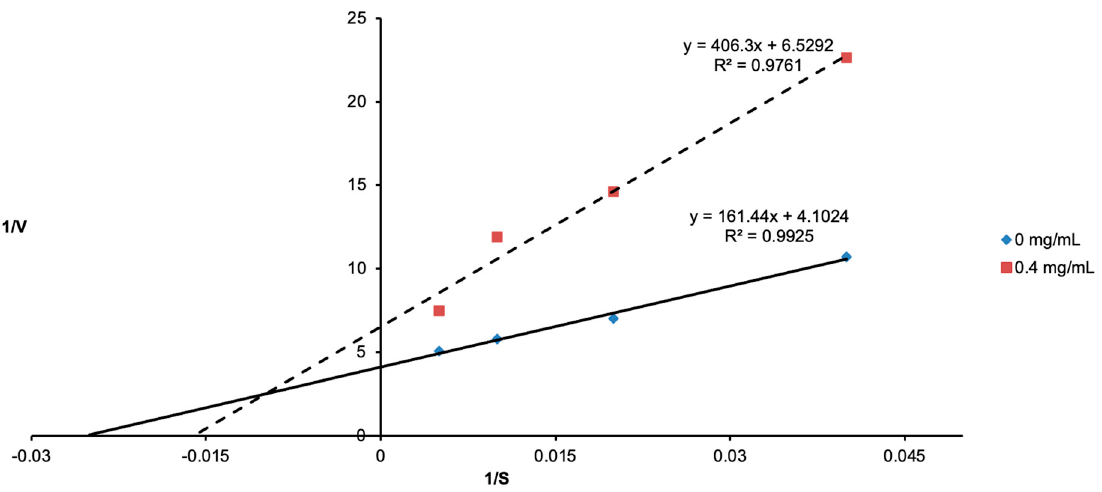
Figure 3. Lineweaver-Burk plot of conversion of L-DOPA to dopachrome by tyrosinase in the presence and absence of kojic acid.